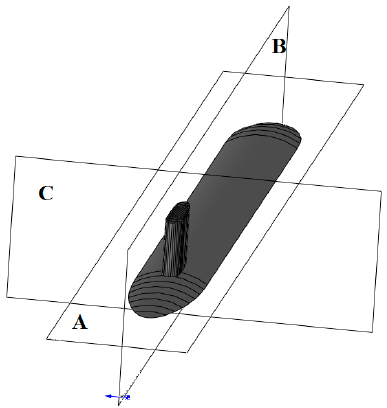
Figure 3. The diagram of the planes. Plane A is in the longitudinal direction, Plane B is in the longitudinal direction, and Plane C is in the transversal direction.